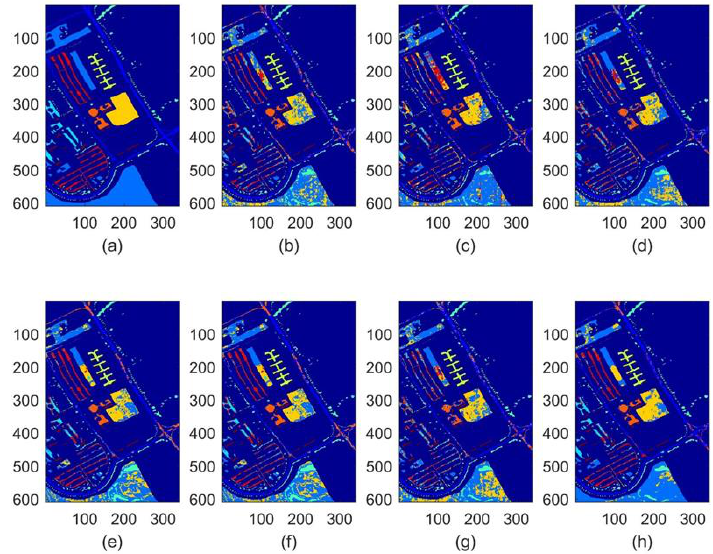
Figure 4. Classification maps for Pavia University. ( a ) Ground truth, ( b ) BH, ( c ) LDFA, ( d ) LPP, ( e ) NWFE, ( f ) PCA, ( g ) SH, ( h ) the proposed SDHE. The different colors indicate the different classes.